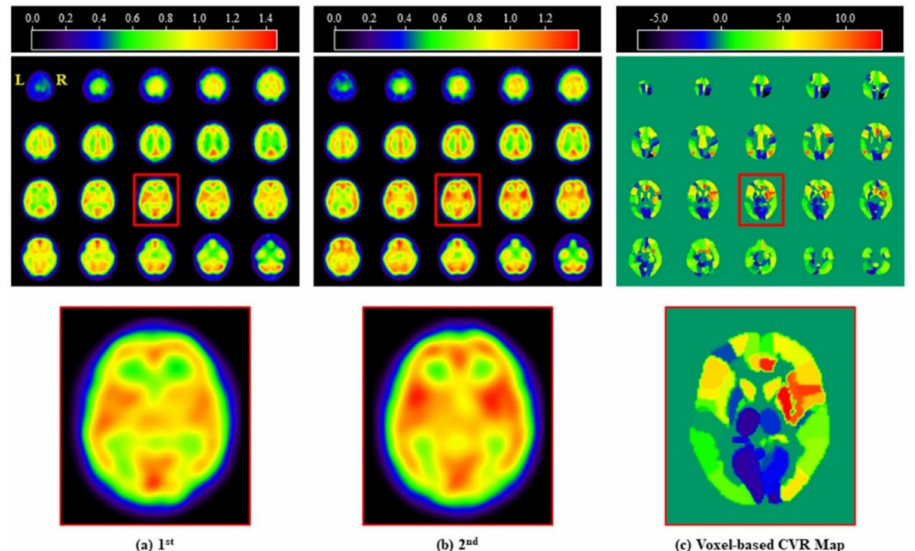
Figure 3. Standardized display supporting the assessment of the SPECT images obtained, including ( a ) first, ( b ) second, and ( c ) voxel-based CVR Map of a representative subject. The colored bars indicate the signal intensity in both ( a ) and ( b ), and the CVR (%) value in ( c ), respectively. Abbreviations: L, left; R, right.